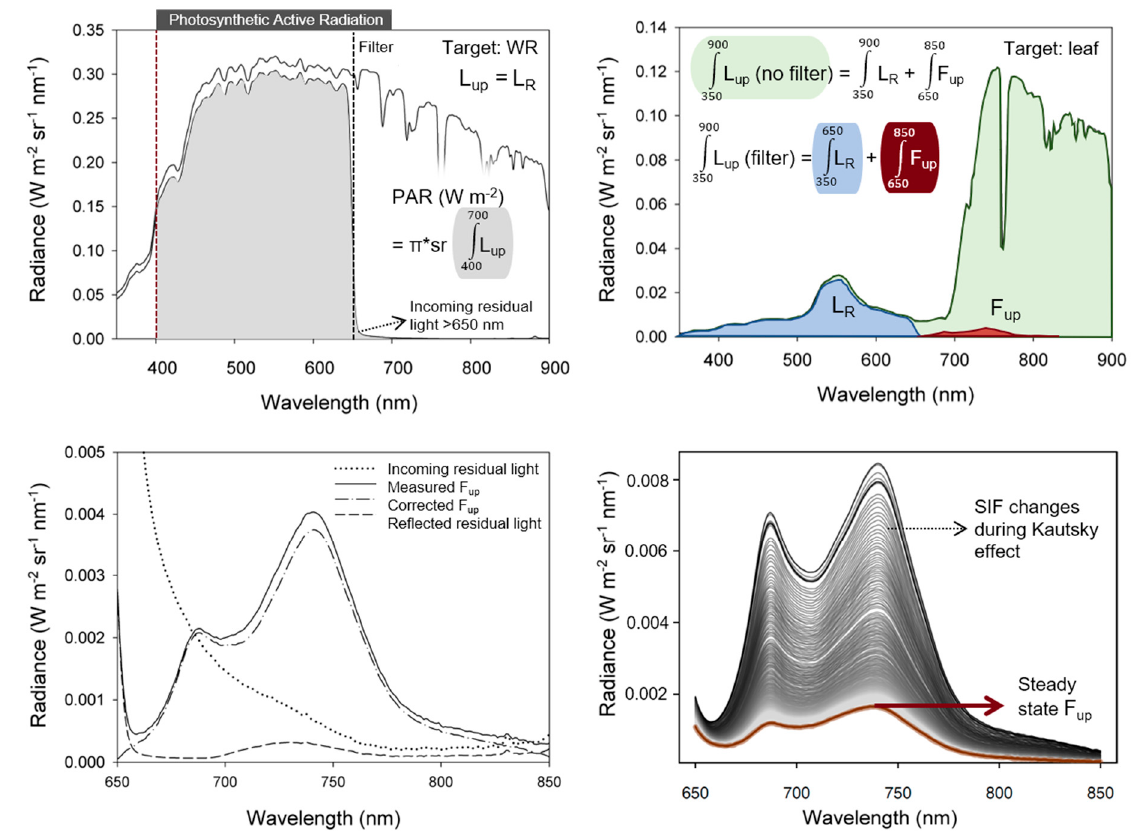
Figure 3. FluoWat leaf clip measurements for incoming radiance with and without filter and the corresponding received PAR calculation (up, left), upward radiance flux (L up ) typically measured perpendicularly to the illuminated adaxial leaf surface (up, right) (modified from [63]), correction for light contaminating the F signal (here: reflected residual light transmitted by the filter) by subtracting the light contamination from the measured upward emitted fluorescence (F up ) (down, left), and illustration of the dynamic F signal during sudden incoming radiance changes shown for a dark-adapted leaf (down, right).